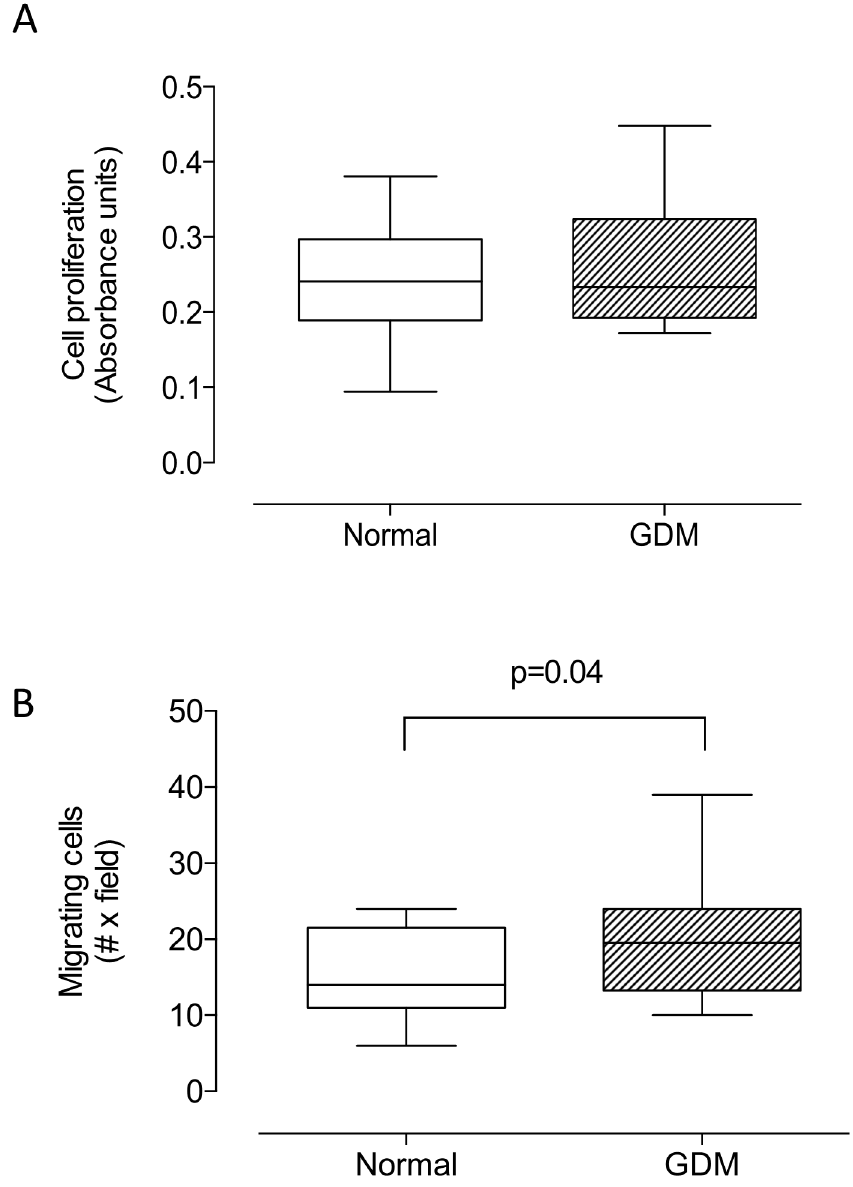
Fig 5. Cell proliferation and migration in HUVEC from gestational diabetes. A) Cell proliferation measuredby MTS assay in HUVEC from normal(Normal, white bar) and gestational diabetes mellitus (GDM, hatchedbar) pregnancies. B) Cell migration as in A. In A, n = 8–11; in B, n = 13 in each